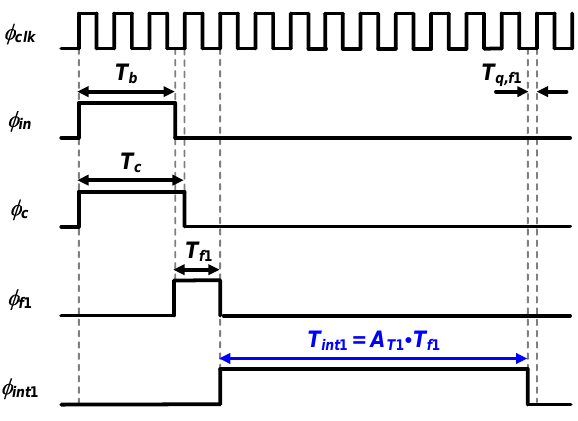
Figure 5. Timing diagram of the proposed TDC in Mode B.